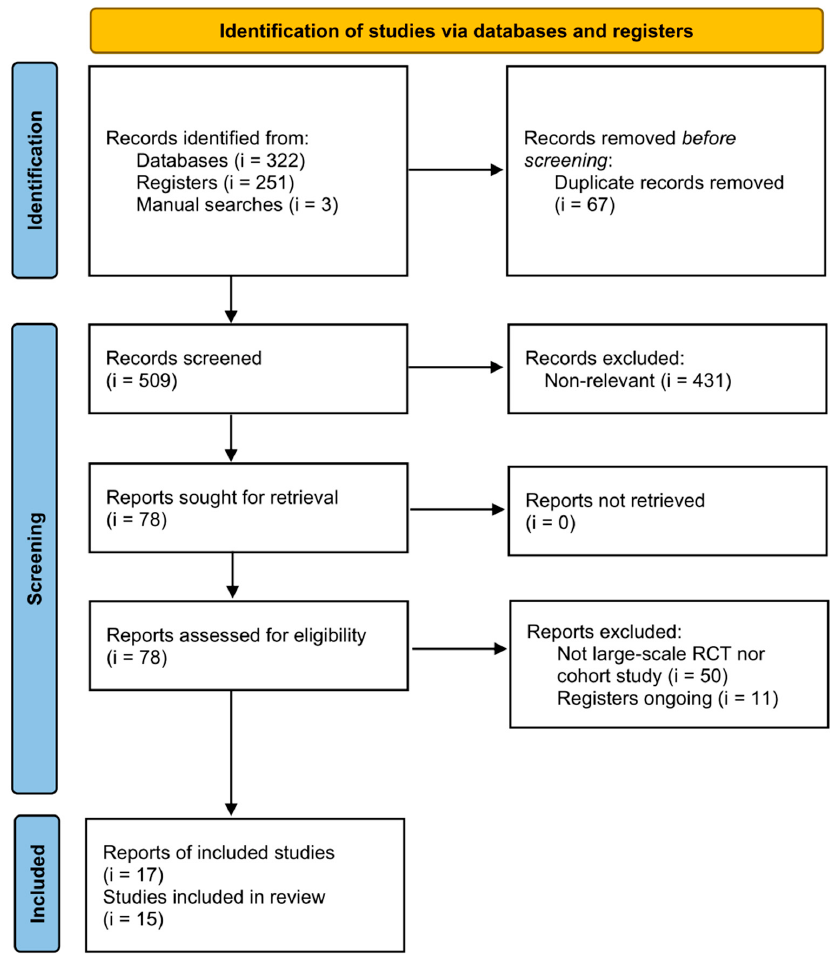
Figure 1. Preferred Reporting Items for Systematic Review and Meta-Analysis flow diagram of evidence selection. Table 1. Characteristics of the studies in this systematic review and